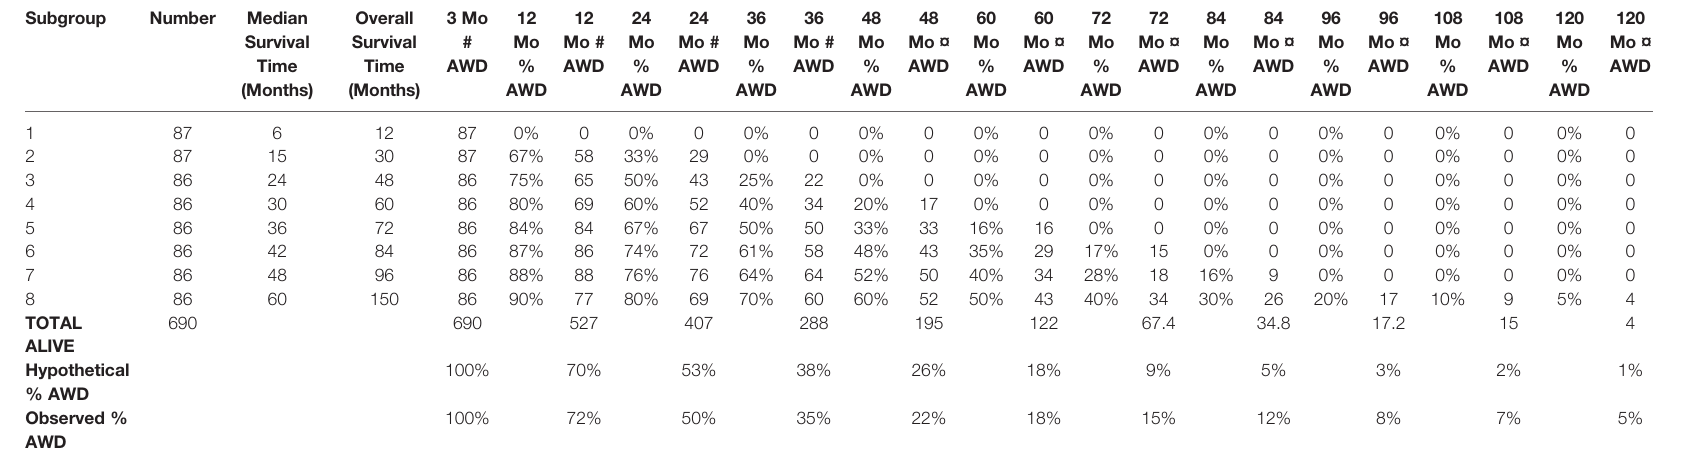
TABLE 2 | The total 690 stage IV NSCLC patients with 3.2 – 120.0 months of follow-up, divided into 8 hypothetical subgroups according to the linear tangent method (see text).